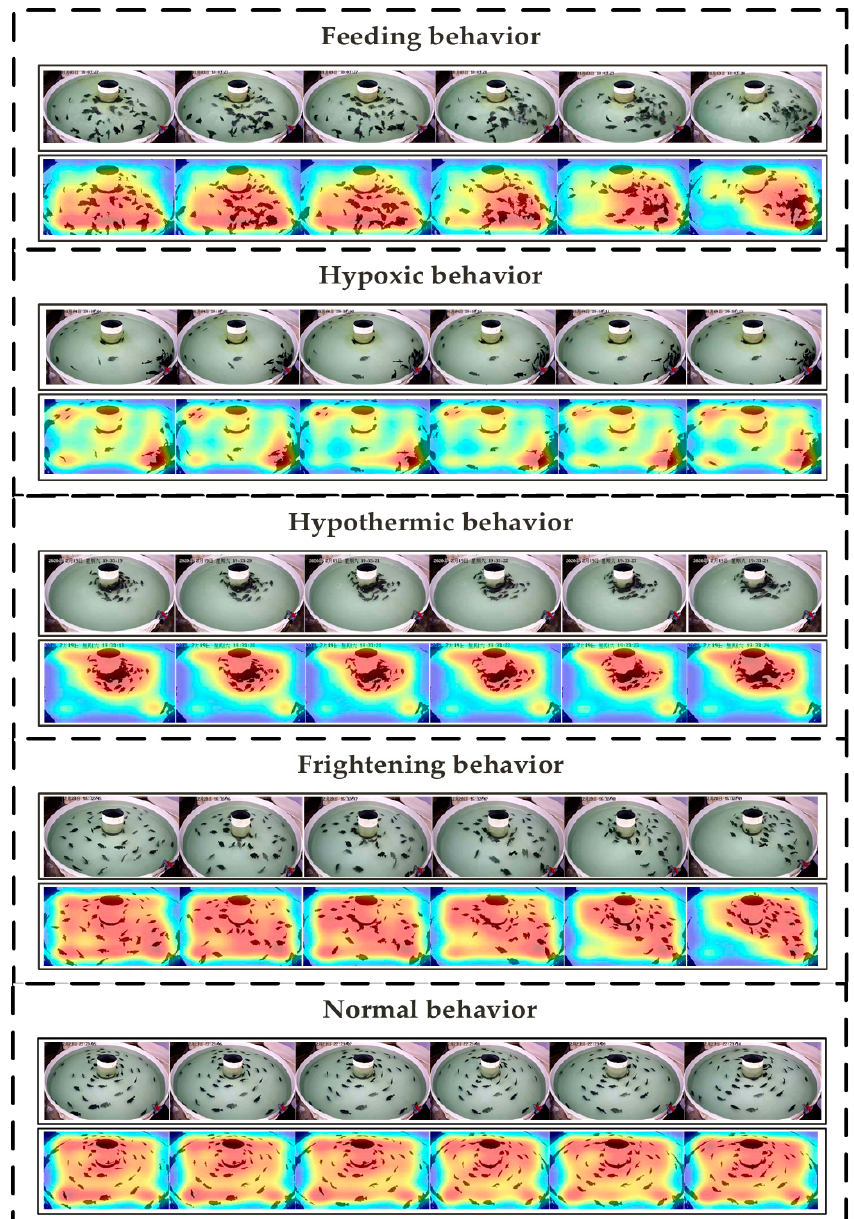
Figure 9. Visualization of 3D CNN features of five behaviors.